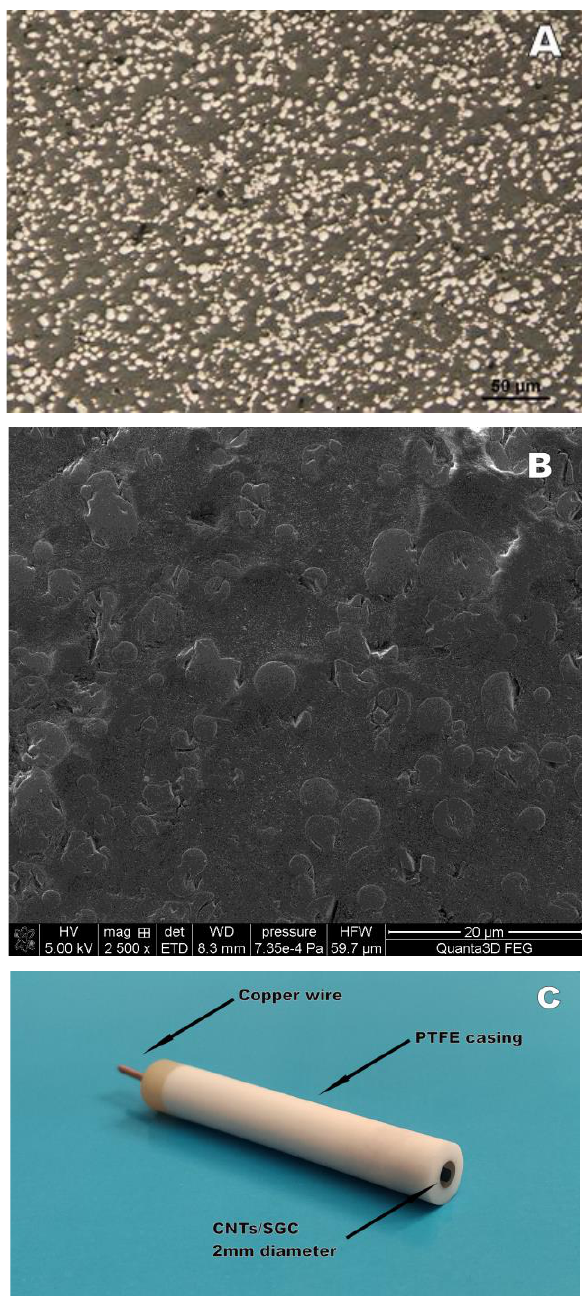
Figure 1. A microscopic image of the CNTs/SGC electrode in 50 µm scale obtained by the Nikon ECLIPSE MA200 inverted metallurgical microscope ( A ). A microscopic image of the CNTs/SGC electrode in 20 µm scale obtained by the Quanta 3D FEG high-resolution scanning electron microscope ( B ). A picture representing the construction of the electrode ( C ).